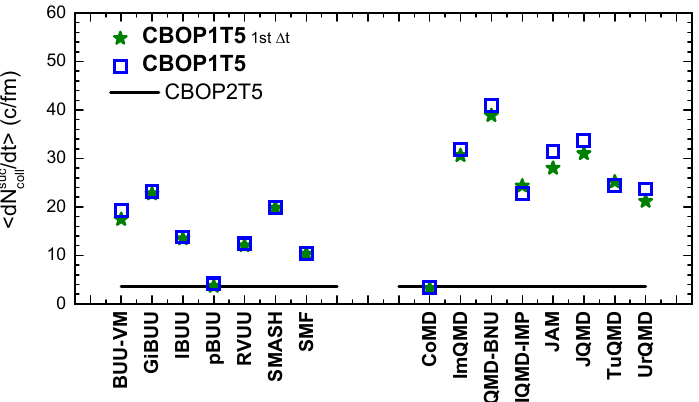
Figure 3. (Color on-line) Comparison of collision rates in box calculations at normal density and temperature T = 5 MeV (denoted as CBOP1T5) for different BUU-type (left) and QMD-type (right) codes. Star symbols give the result for the first timestep, square symbols time-averaged rates. They are compared to a numerical essentially exact result for this case (solid line, denoted as CBOP2T5). For the identification of different codes see Ref. [22], from where this figure is taken.